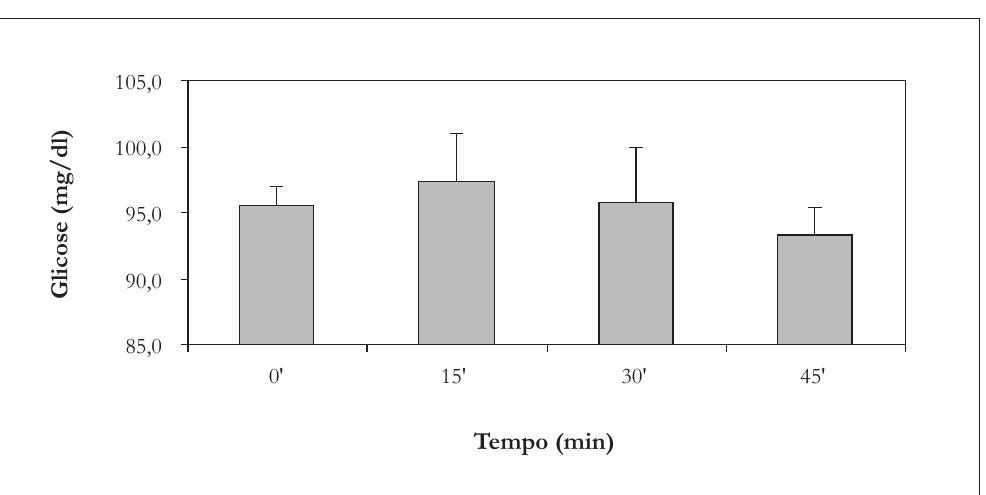
Figura 4 - Concentrações plasmáticas de glicose nos intervalos de 0 a 45 min. Os valores representam a média ± e.p.m. das 6 sessões de fisioterapia. Não houve diferença estatística significativa entre os intervalos de tempo